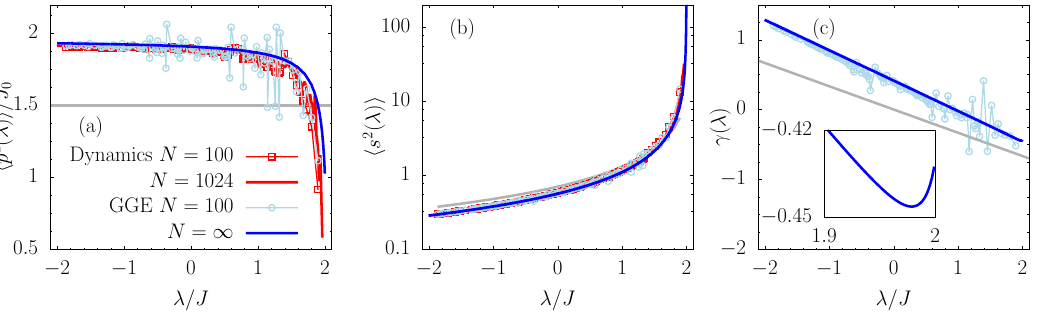
Figure 12: Comparison of the dynamic and GGE results in phase II. The quench = 1.5 J parameters are T and J = 1.7 J . (a) 〈 p 2 ( λ ) 〉 , (b) 〈 s 2 ( λ ) 〉 and (c) GGE 0 0 0 Lagrange multipliers γ ( λ ) . The N → ∞ GGE results can be confronted to the dy- namic ones with finite N . Note the fast grow of 〈 s 2 〉 at the edge of the spectrum GGE in (b) accompanied by a vanishing 〈 p 2 〉 in (a). The grey horizontal line in (a) GGE = 1.5 J is at the initial temperature T , the grey curve in (b) is the initial average 0 0 〈 s 2 ( 0 + ) 〉 and in (c) the grey straight line represents the pre-quench equilibrium µ i . c . λ/ ( 2 T J ) = − 0.333 λ/ J . The zoom highlights values γ ( λ ) = − β (cid:48) λ ( 0 ) / 2 = − J 0 0